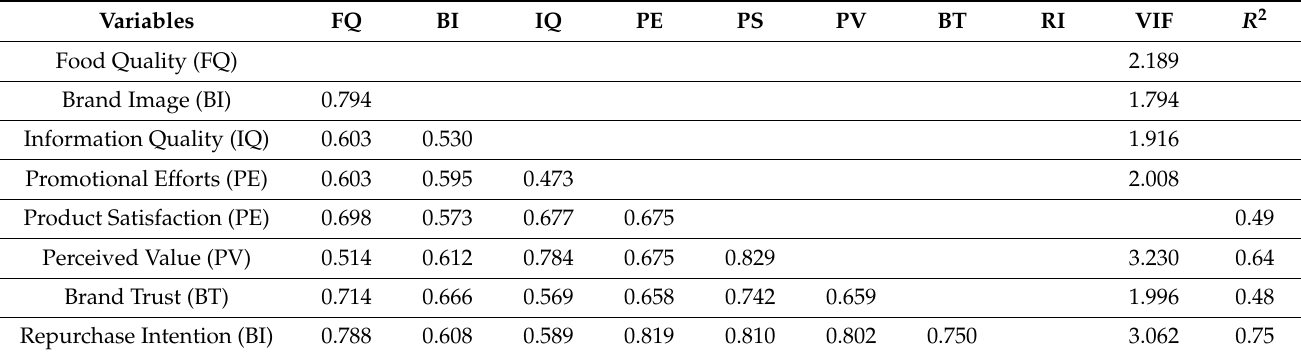
Table 4. Heterotrait–Monotrait Ratio (HTMT).